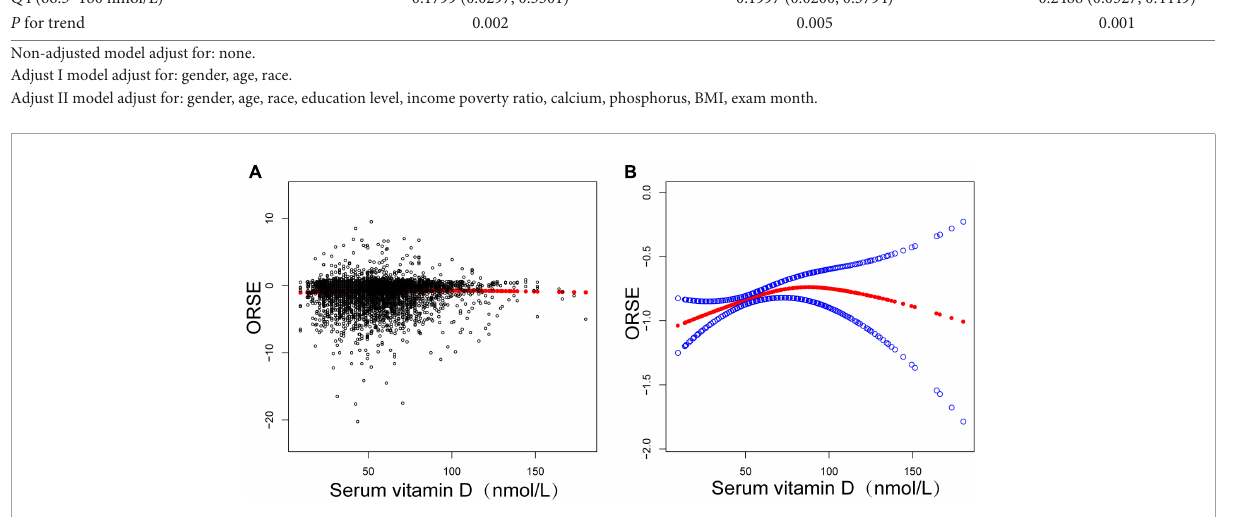
FIGURE1 (A) Scatterplot: Each black point represents a sample. (B) Red solid arcs indicate the smoothed curve fit between variables. The area between two blue dotted lines is expressed as a 95% CI. Adjusted for age, sex, race, household income, education, body mass index, blood calcium, serum phosphorus, and other